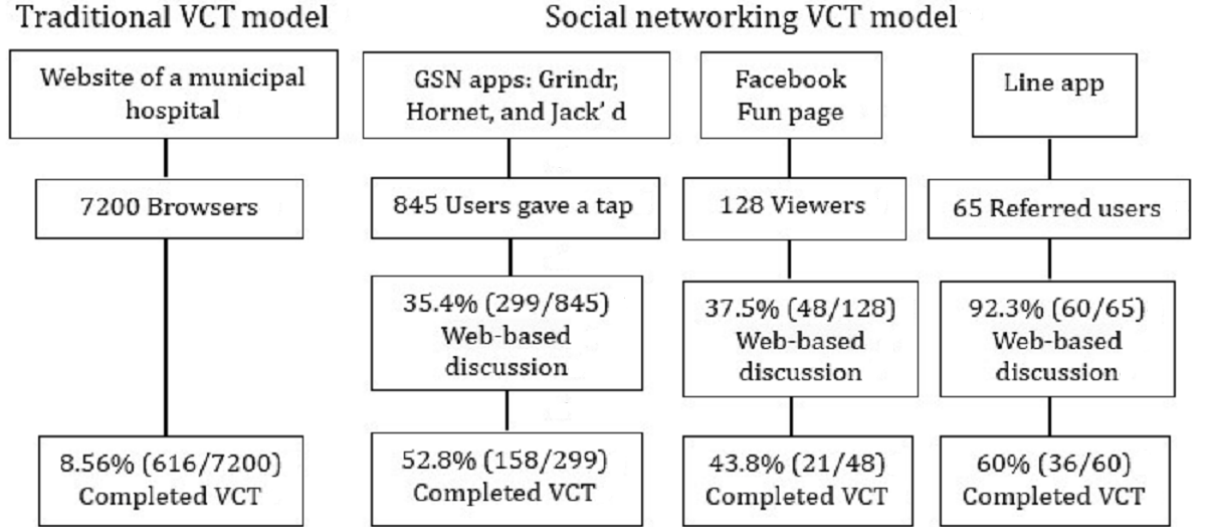
Figure 3. Attrition diagram for the 2 voluntary counseling and testing models. GSN: geosocial network; VCT: voluntary counseling and testing.